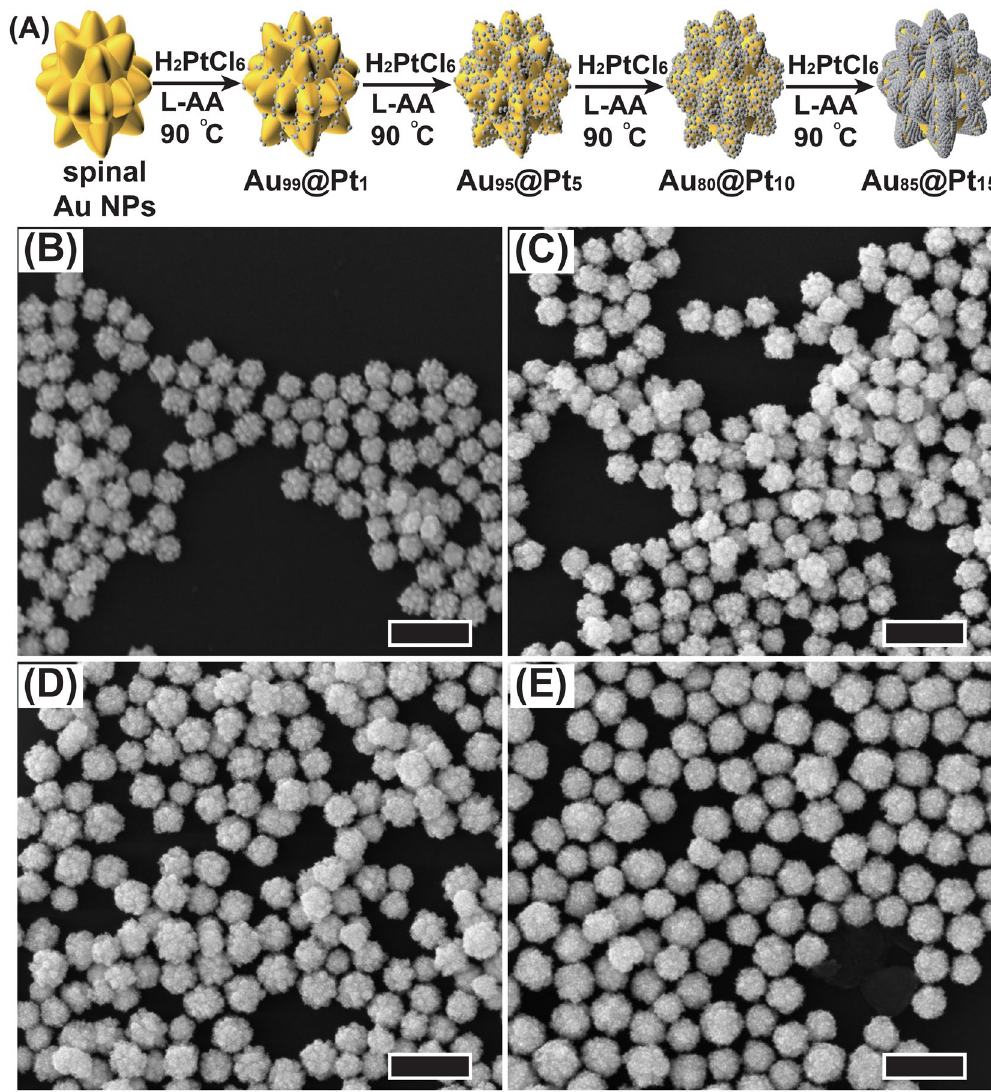
Figure 1. ( A ) Reaction scheme showing the morphological and structural changes involved in the fabrication of Au@Pt NPs with different Pt ratios. SEM images of Au@Pt NPs with different Pt source amount-modulated spiny Au NPs. The scale bar at the lower right corner indicates 200 nm. ( B ) Au 99 @Pt 1 NPs ( C ) Au 95 @Pt 5 NPs ( D )